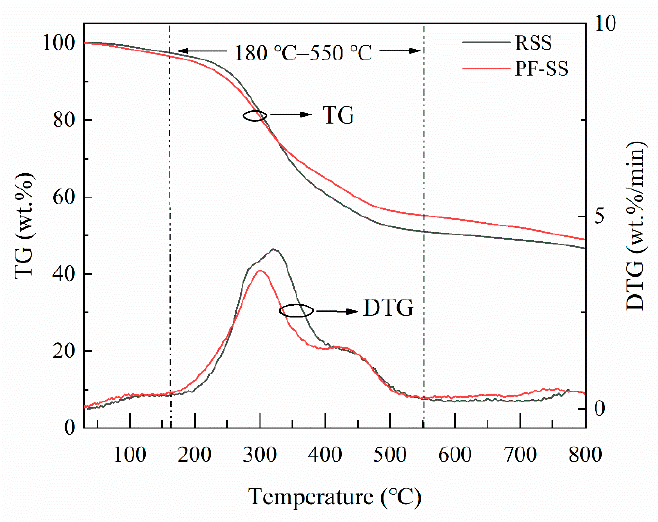
Figure 1. Thermogravimetric (TG) and reciprocal thermogravimetric (DTG) curves of sludge.